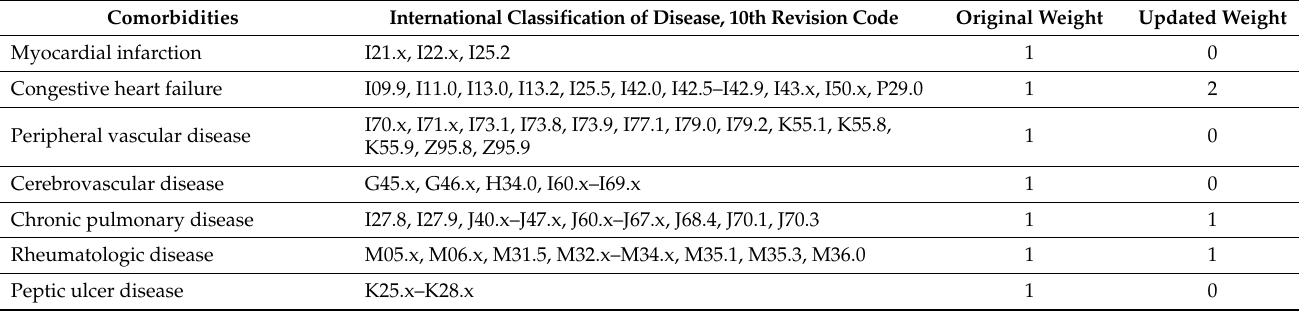
Table A1. List of Charlson’s comorbidities and these